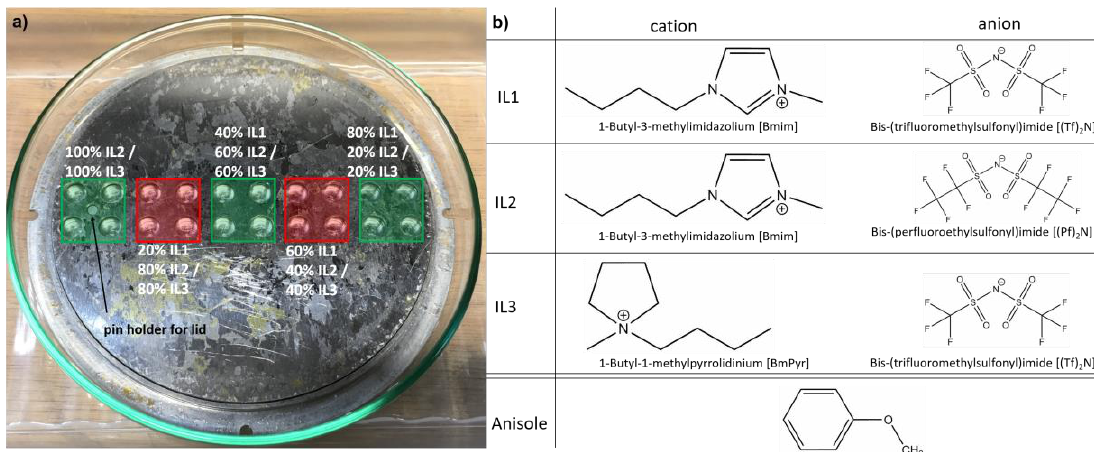
Figure 1. ( a ) Photo of the 20-cavity plate (100 mm diameter). The applied arrangement of ionic liquid (IL) (mixtures) is indicated. IL1 was mixed with IL2 or IL3 respectively in steps of 20 vol.% from pure IL2/IL3 to a mixture of 20 vol.% IL2/IL3 with 80 vol.% IL1 before deposition. Anisole was added in the same volumetric steps to already-sputtered pure Ag in IL1 . The chemical structures of the IL ions and anisole are shown in ( b ). IL2 and IL3 differ only by the anion and cation, respectively, with respect to IL1 . The drawings of the chemical structures are not depicted in the same size format (drawn with “ChemDraw Professional” from PerkinElmer).